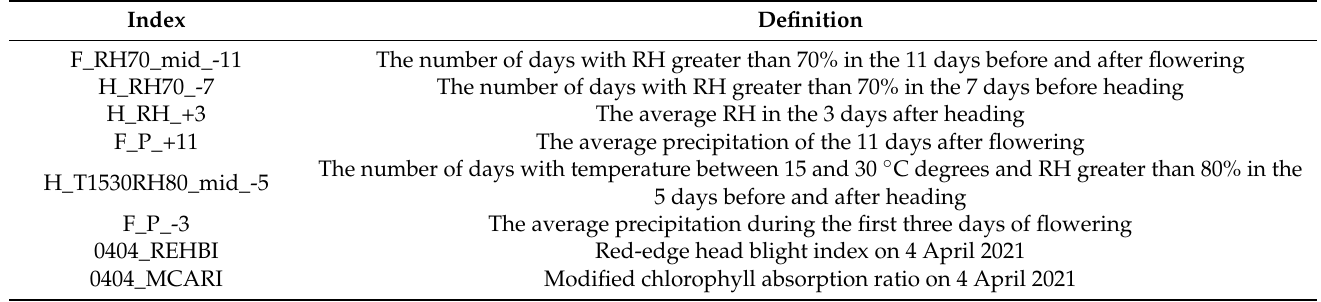
Table 1. Feature selection results based on logistic and L1 regularization and Fisher scores (29 April 2021).